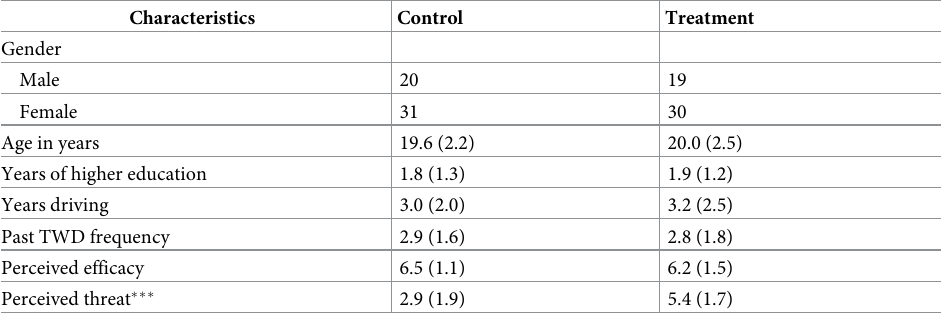
Table 1. Demographic characteristics and perceived efficacy and threat for the control and treatment